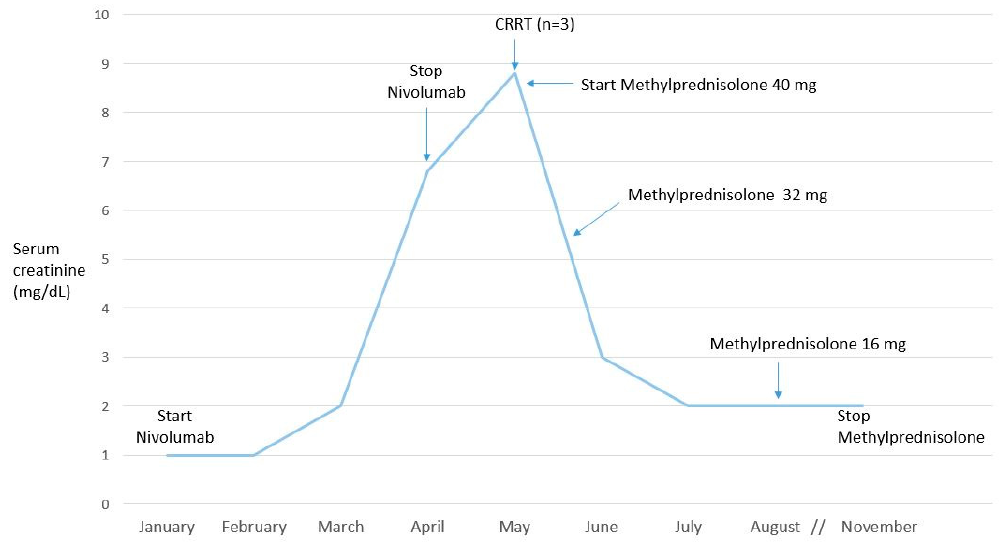
Table 1. Function of constitutively expressed Vascular Endothelial Growth Factor (VEGF) and VEGF receptors in the normal kidney.